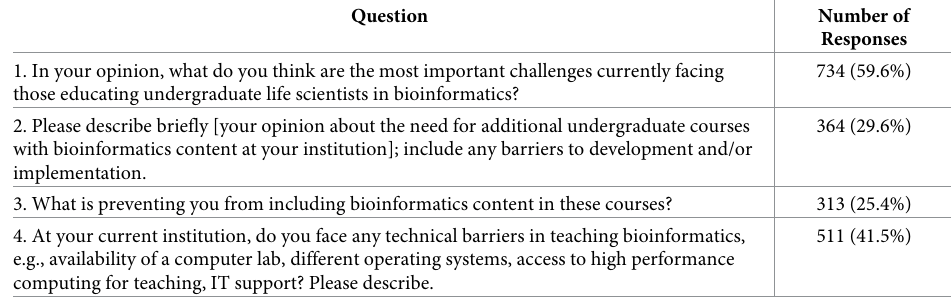
Table 1. Survey questions about barriers faculty face in integrating bioinformatics into undergraduate life sci- ences instruction. Question Number of